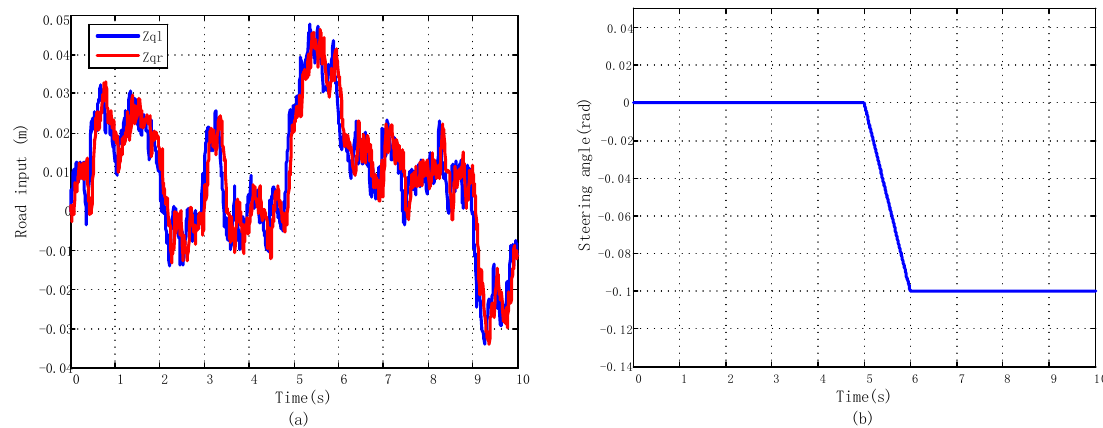
Figure 13. The input signals of vehicle: ( a ) the random road; ( b ) the steering angle under J-turn maneuver.